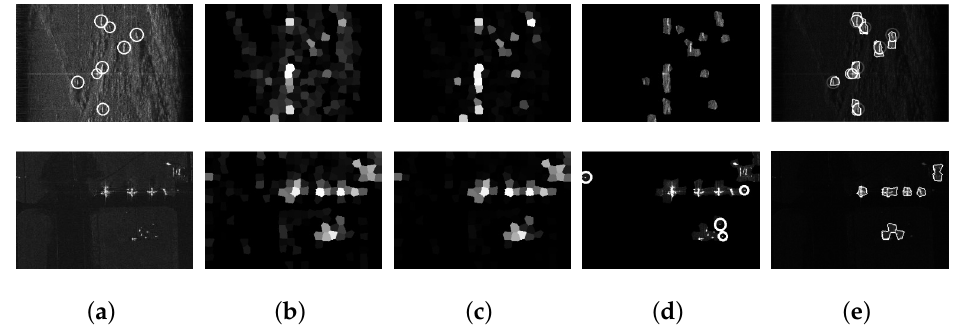
Figure 8. ( a ) Original SAR image; ( b ) Iterate the outlier degree; ( c ) The results of the recursive correction; ( d ) The results of global detection; ( e ) The results of local